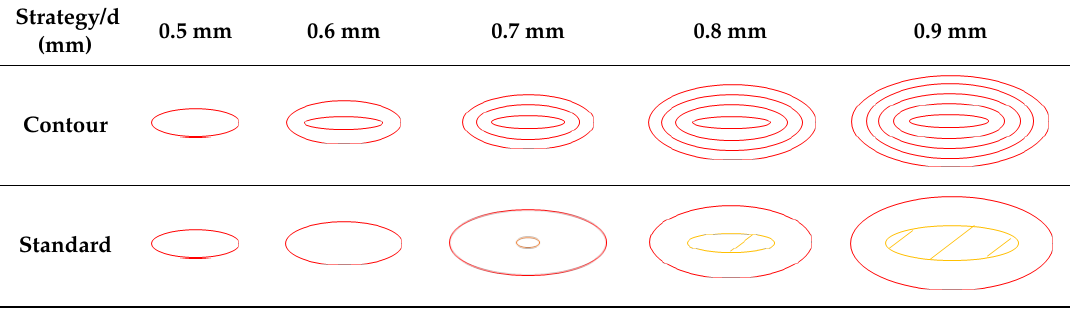
Figure 5. ( a ) Shape of the samples with inclination of 90°; ( b ) contour strategy with different overlap parameter. In this experiment, the laser strategy for lattice structure production created only by contour